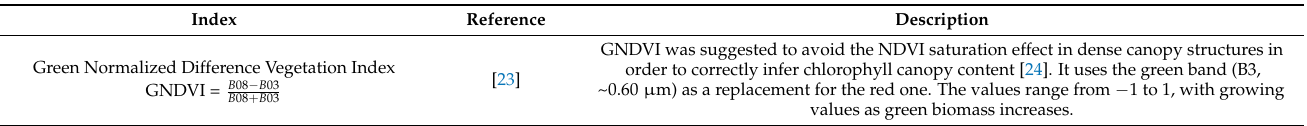
Table 2. Vegetation indices formula and